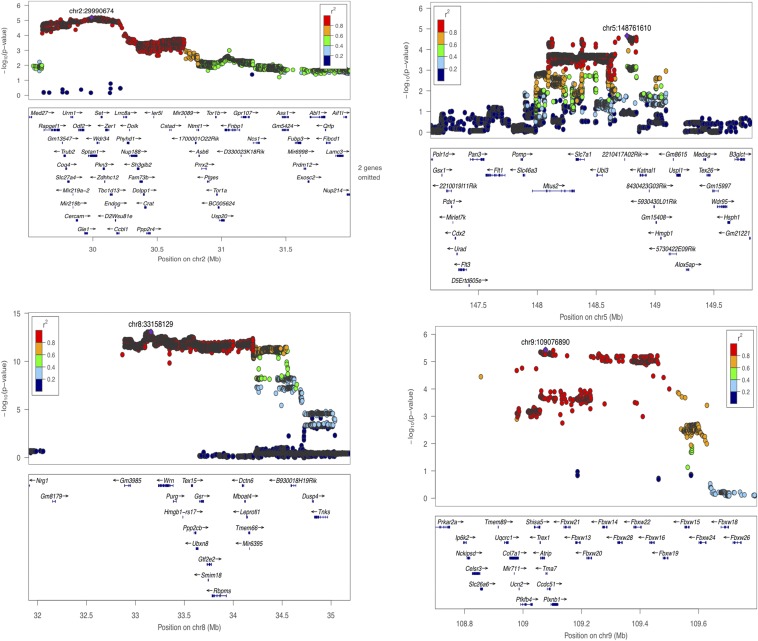
Genome-wide significant loci for micronucleus formation on chromosomes 2, 5, 8, and 9. The −log10 P-values of imputed single-nucleotide polymorphisms (SNPs) associated with micronucleus levels are shown on the Y axis. The X axis gives chromosome and position in megabases (Mb). Genes within the regions are shown in the bottom panels (for clarity, as indicated on the figure, some gene names have been omitted). Linkage disequilibrium of each SNP with top SNP, shown in large purple diamond, is indicated by its color. The plots were drawn using LocusZoom (Pruim et al. 2010).